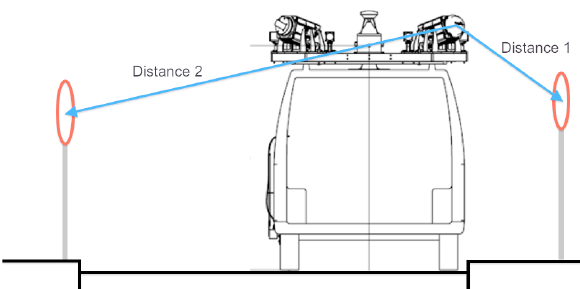
Figure 4. Distance from signs at both sides of vehicle to the same LiDAR sensor. 4.1.2.